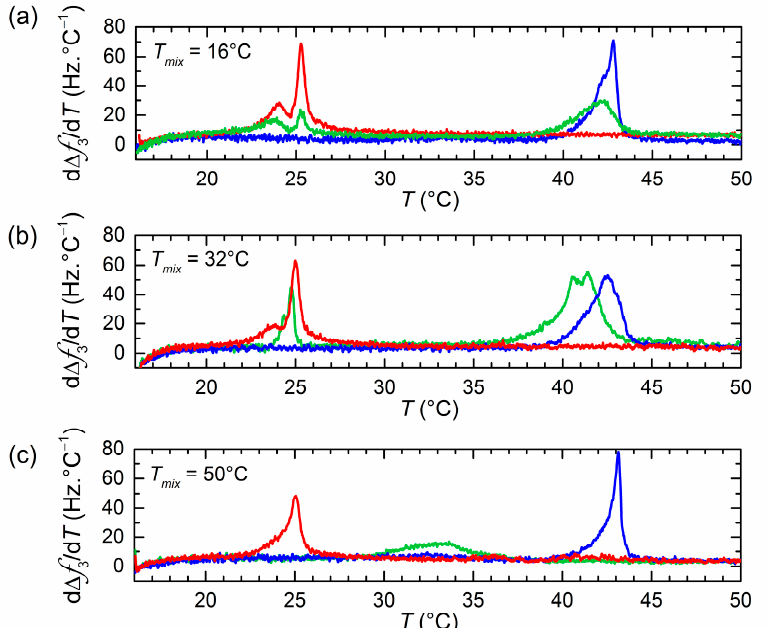
Figure 2. Temperature dependence of d Δ f 3 /d T (third overtone) upon the first heating for pure DMPC LUVs (red), pure DPPC LUVs (blue), and 24 h DPPC/DMPC mixture (green) adsorbed at T = 16 °C ( a ), T = 32 °C ( b ), and T = 50 °C ( c ) on Au-coated quartz surfaces.